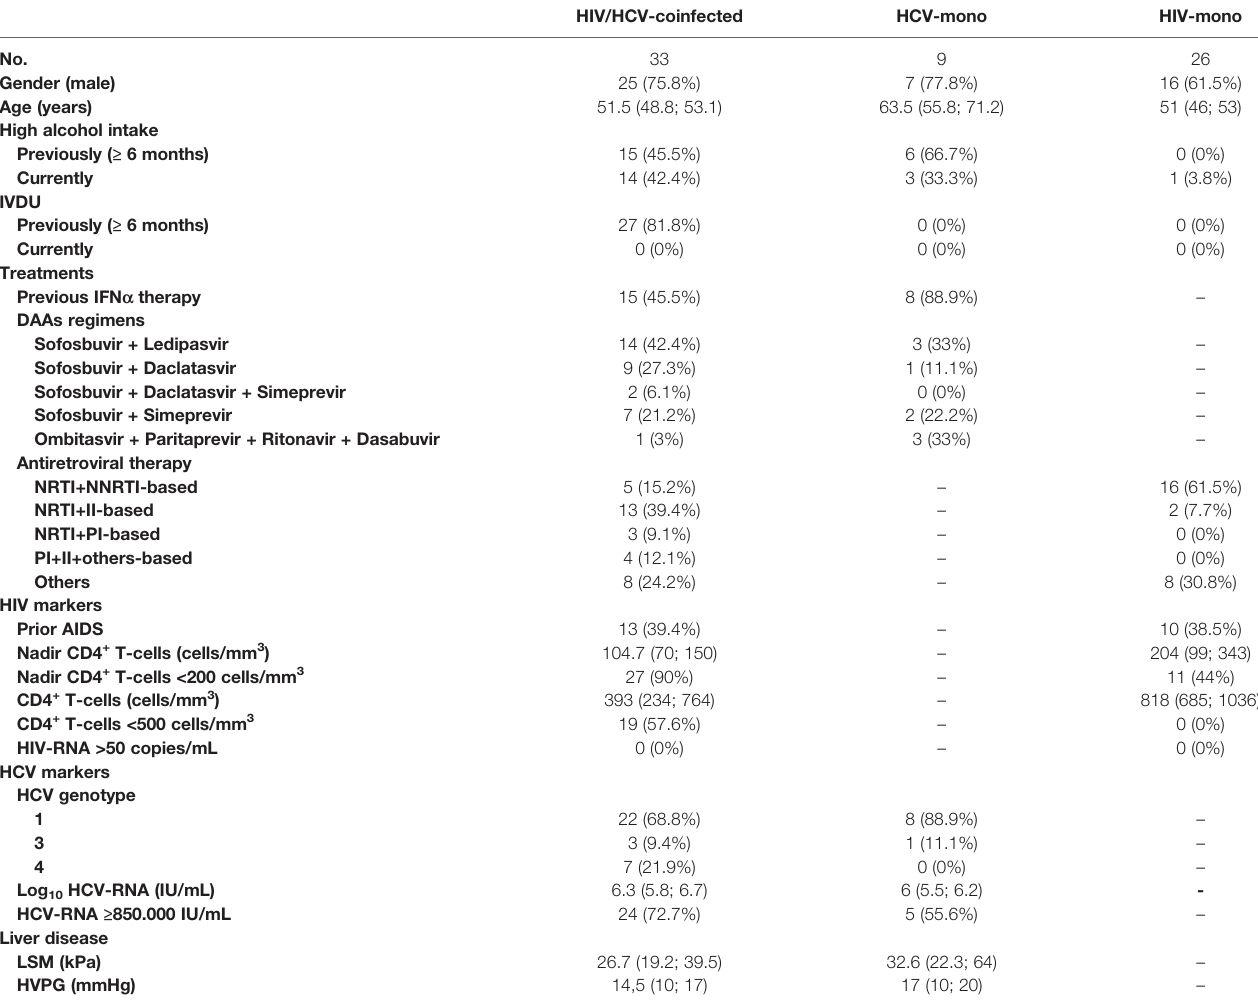
TABLE 1 | Summary of patient characteristics at